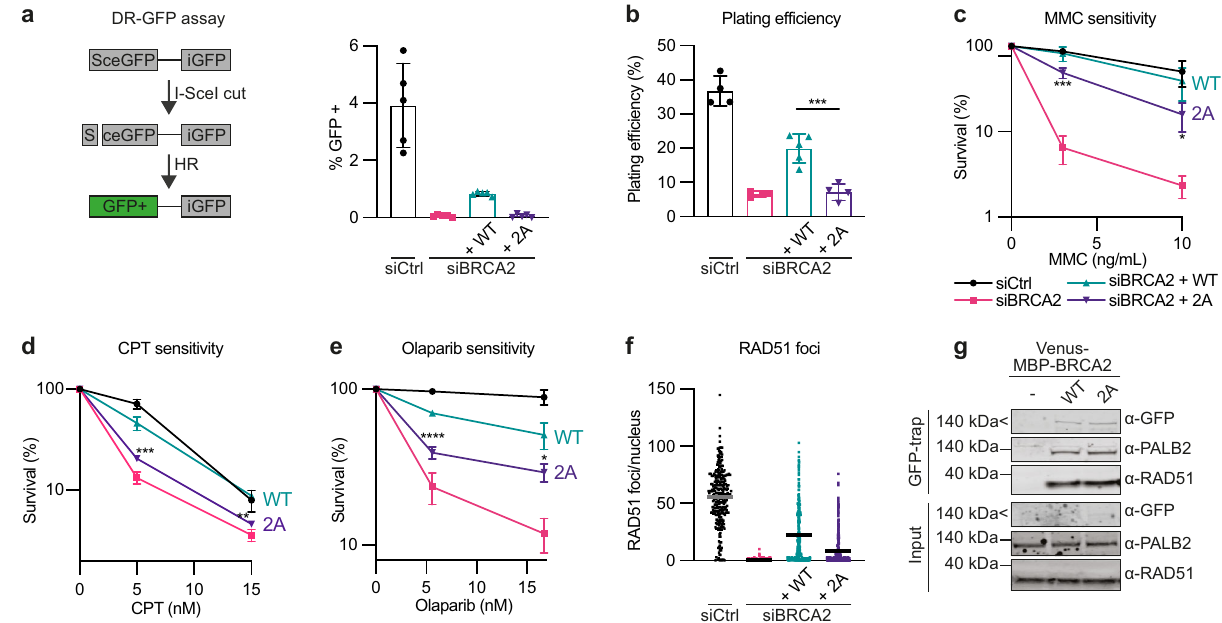
Fig. 2 The BRCA2-PP2A-B56 complex is required for DNA repair by HR. a Left: Schematic of the DR-GFP reporter assay. Right: Percentage of GFP positive (HR completed) HeLa DR-GFP Flp-In parental cells or stably expressing siRNA-resistant mCherry-MBP-BRCA2 WT or 2A cDNAs after transfection with Ctrl or BRCA2 siRNAs and an I-SceI-encoding plasmid, quanti fi ed by fl ow cytometry. Background values (without I-SceI) were subtracted. Data are presented as means ± standard deviations from fi ve independent experiments, and individual data points are indicated. b – f U2OS Flp-In T-REx parental cells or stably expressing siRNA-resistant Venus-MBP-BRCA2 WT or 2A cDNAs were transfected with Ctrl or BRCA2 siRNAs. b – e Colony formation assays showing plating ef fi ciency ( b ), MMC sensitivity ( c ), CPT sensitivity ( d ), and Olaparib sensitivity ( e ). Data are presented as means ± standard deviations for three independent experiments except for b and c for which siBRCA2 + WT is n = 5 and the remaining conditions are n = 4. One-way ANOVA analyses with Dunnett ’ s multiple comparison tests were performed to compare each condition to siBRCA2 + WT. * p < 0.5, ** p < 0.1, *** p < 0.001, **** p < 0.0001. f RAD51 nuclear foci in cells synchronized to S-phase with a thymidine block, released from the block and treated for 1 h with MMC, and then allowed to recover for 8 h before immuno fl uorescence microscopy. Each dot represents an individual nucleus, and means are indicated for 272 (siCtrl), 287 (siBRCA2), 239 (siBRCA2 + WT), or 297 (siBRCA2 + 2A) nuclei. The experiment is a representative of three independent experiments. g Western blot of the co-puri fi cation of RAD51 and PALB2 with Venus-MBP-BRCA2 WT and 2A from U2OS Flp-In T-REx cells representative of three independent af fi nities between B56 and various phosphorylated BRCA2 peptides by ITC (Fig. 3d, Supplementary Fig. 5). Phosphorylation of S1123 and S1128 increased the binding af fi nity four and two fold, respectively, while the double phosphorylated peptide (S1123/S1128) had an eight-fold increase in binding af fi nity. In contrast, phosphorylation of S1106 slightly weakened the interaction.